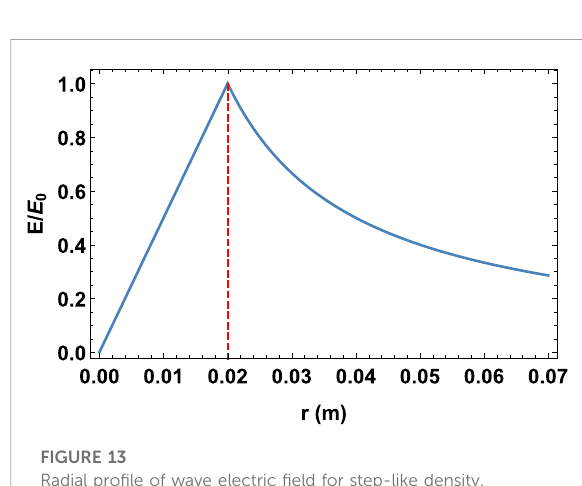
FIGURE 13 Radial pro fi le of wave electric fi eld for step-like